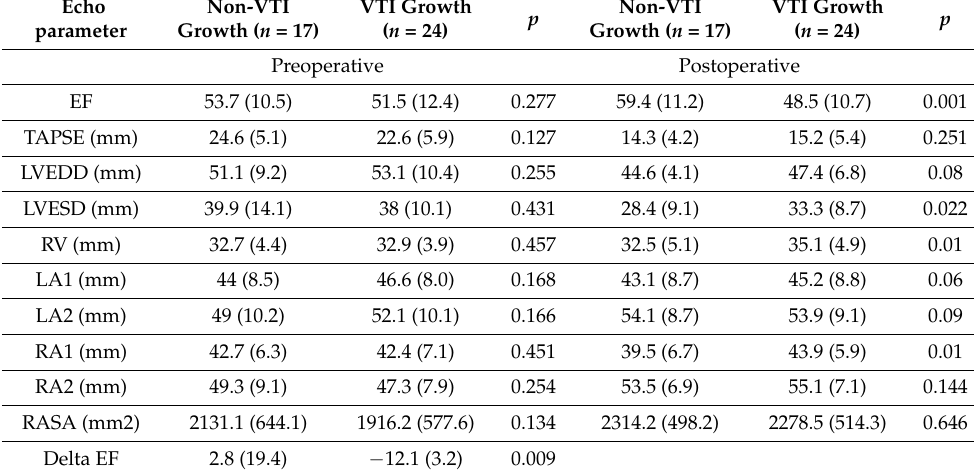
Table 2. Preoperative and postoperative echocardiographic parameters (mean or median (IQR or SD)). Echo